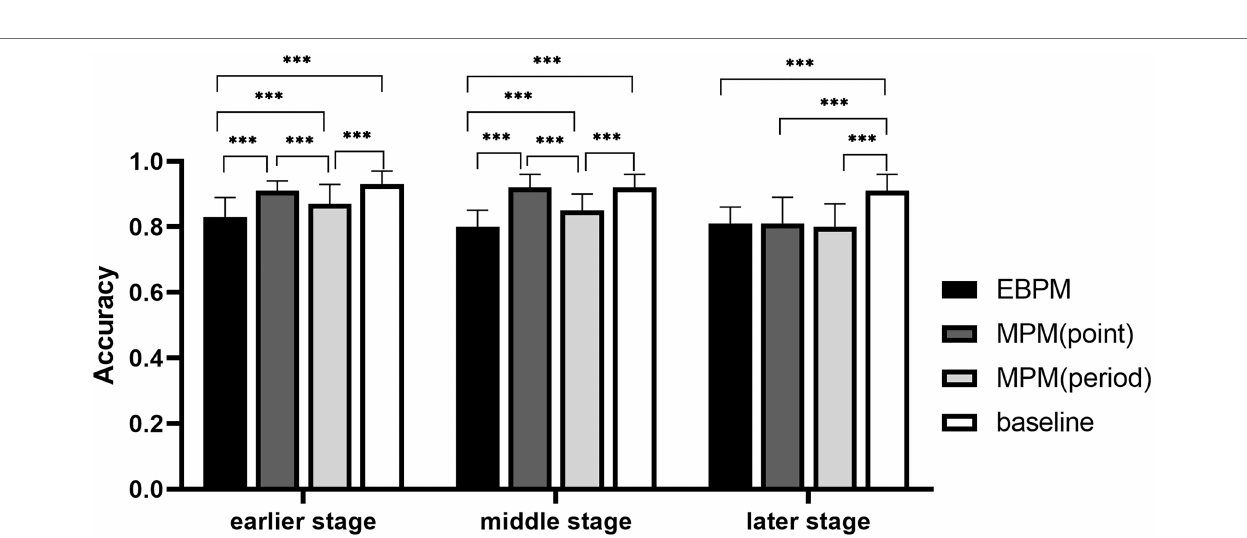
FIGURE 2 | The accuracy of ongoing tasks in different groups at different stages under high cognitive load. *** p <